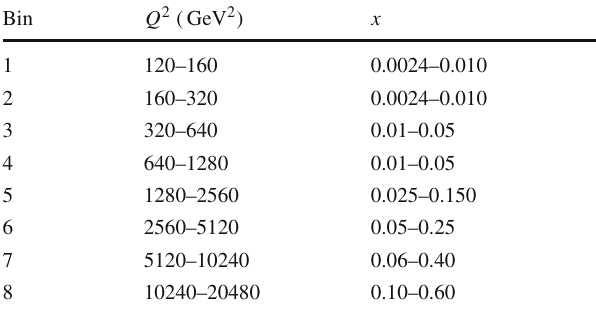
Fig. 5 Distributionsoflog Q 2 / 1GeV 2 − log Q 2 reconstruction methods in individual analysis bins. For better visibil- ity, the data points for each reconstruction method are connected with straight